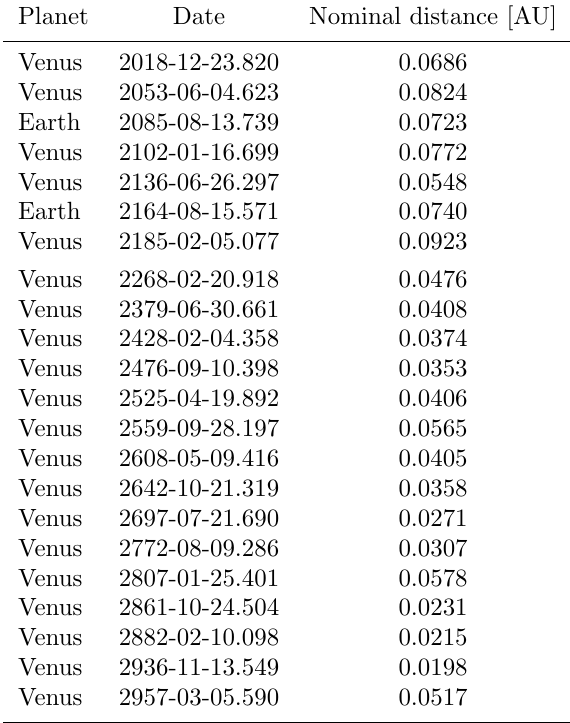
Table 3. Approaches of 2008 OS9 to Earth and Venus for the nominal orbit. For the last group of 15 encounters only the approaches closer than 0.06 AU are presented.